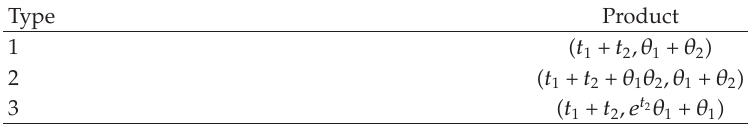
Table 2: Lie supergroup structures on R 1 | 1